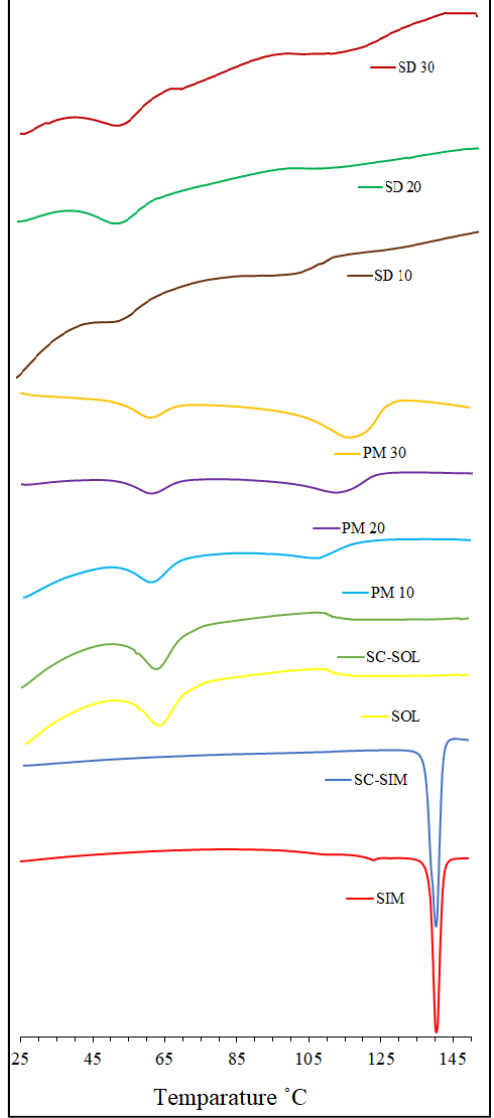
Figure 2. DSC thermogram of Soluplus ® , Simvastatin, physical mixture (PM10, PM20, and PM30 and solid dispersions (SD10, SD20, and SD30) prepared at 50 °C and 150